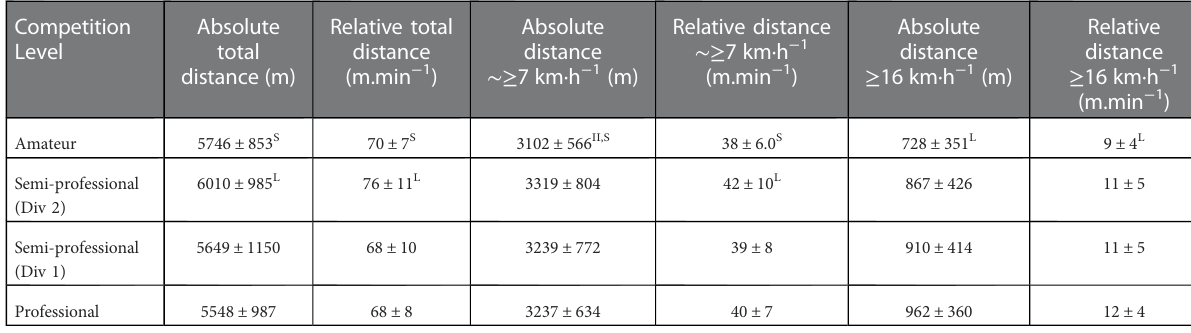
TABLE 1 Absolute and relative distance measurements (mean±SD) in different levels of rugby competition. Competition